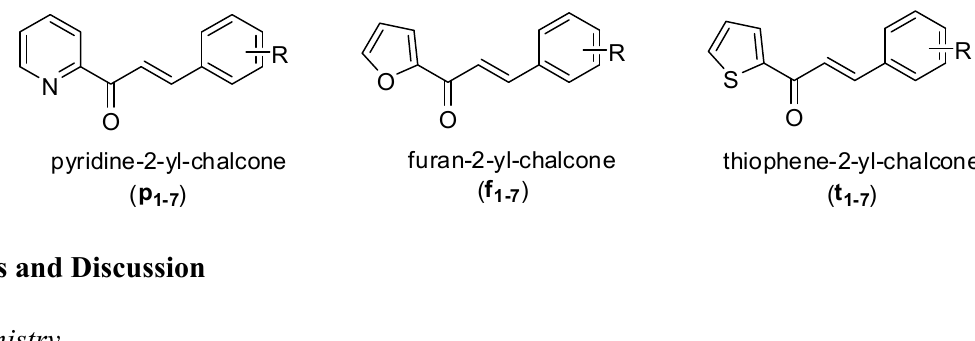
Figure 1. Structure of heterocyclic chalcones obtained from the Claisen Schmidt condensation between heteroaryl methyl ketones and substituted